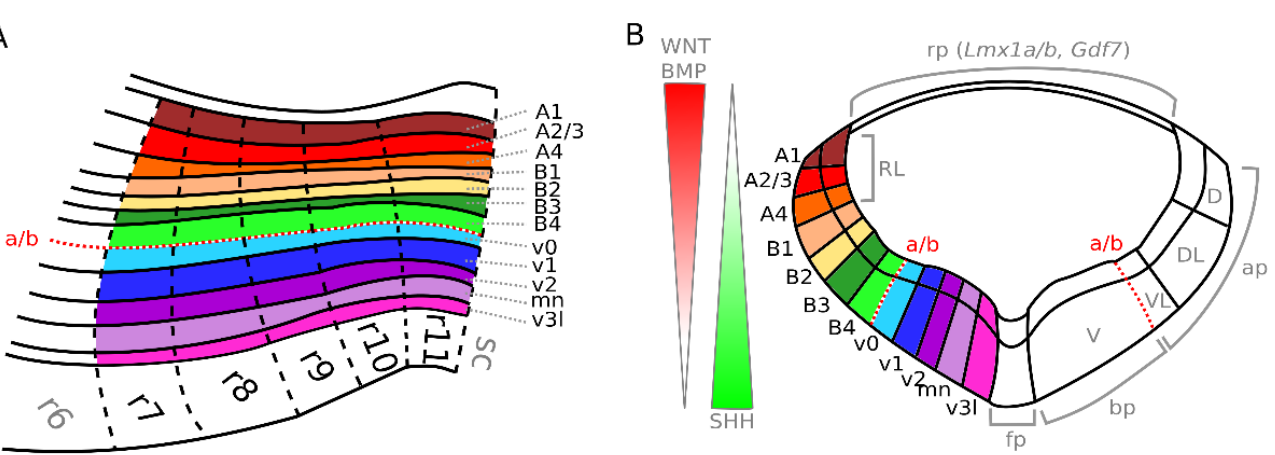
Figure 1. Location of FMUs in the developing medulla oblongata ( A ) Sagittal view of the developing medulla (r7–r11) showing the corresponding FMUs from dorsal to ventral. Different progenitor zones (A1–v3l) are shown with different colors. ( B ) Coronal view of developing the medulla showing the corresponding FMUs. Different progenitor zones (A1–v3l) are shown with different colors. Dorsalizing WNT and BMP signaling from the rp and ventralizing SHH signaling from the fp influence the development of the different FMUs. Expression of Lmx1a / b and Gdf7 defines the roof plate. Figures are based on Nieuwenhuys and Puelles (2016) [17] and Di Bonito and Studer (2017) [12]. a/b—sulcus limitans, boundary between alar and basal plate; rp—roof plate; ap—alar plate; bp—basal plate; fp—floor plate; RL—rhombic lip; D—dorsal area; DL—dorsal-lateral area; VL—ventral-lateral area; V—ventral area.